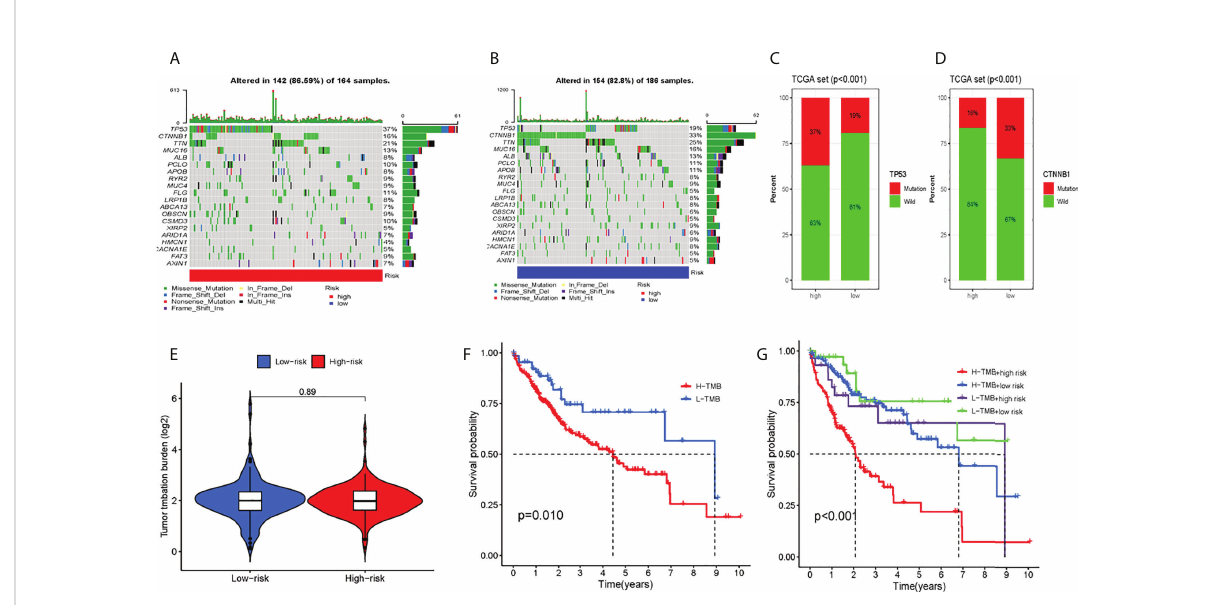
FIGURE 6 Tumor somatic mutation and differential tumor mutational burden (TMB) and survival analysis. The waterfall plot of tumor somatic mutation was established by those with high-risk scores (A) and low-risk scores (B) . (C) TP53 mutation, (D) CTNMBI mutation (E) Analysis of the difference of TMB; (F) TMB survival analysis; (G) Combined survival analysis of TMB and patient risk; Each column represented individual patients. The upper barplot showed TMB. The number on the right indicated the mutation frequency in each gene The right barplot showed the proportion of each variant type. TMB tumor mutational burden.